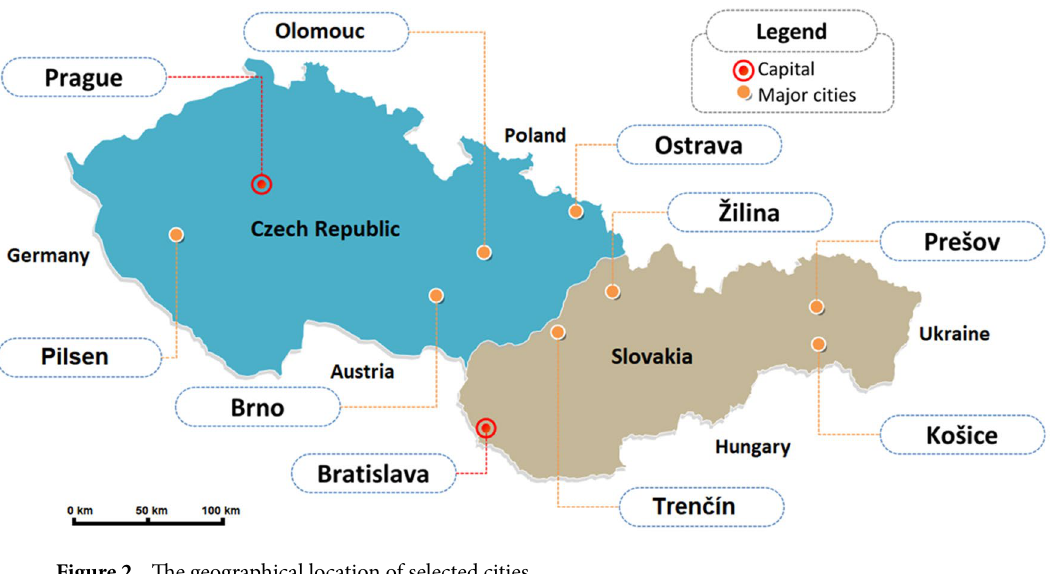
Figure 2. The geographical location of selected cities.